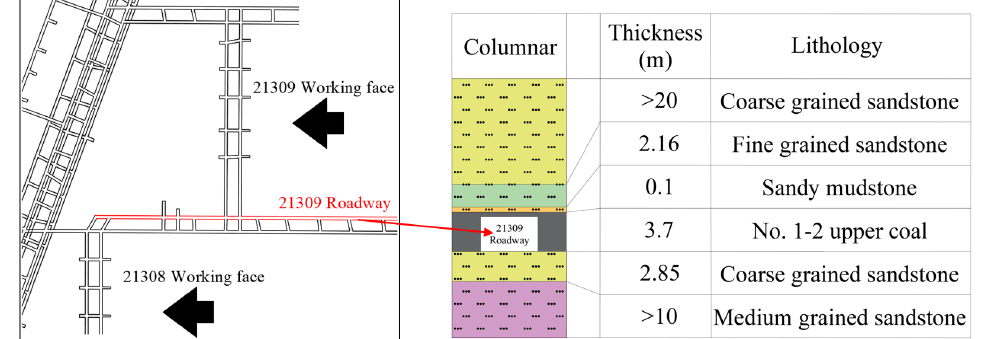
Figure 2. Location of the 21309 roadway and generalized stratigraphy column.